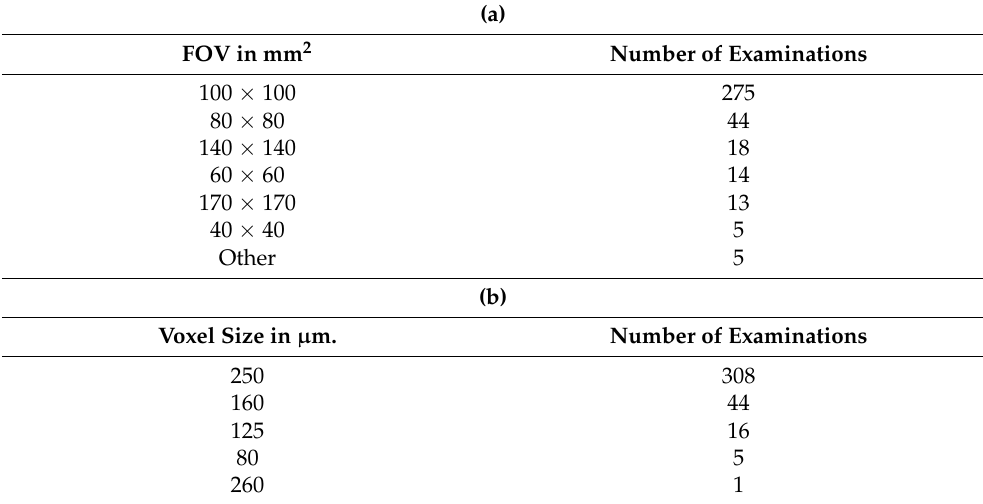
Table 1. ( a ) Number and frequency of applied FOV. ( b ) Number and frequency of voxel sizes used for image reformation.